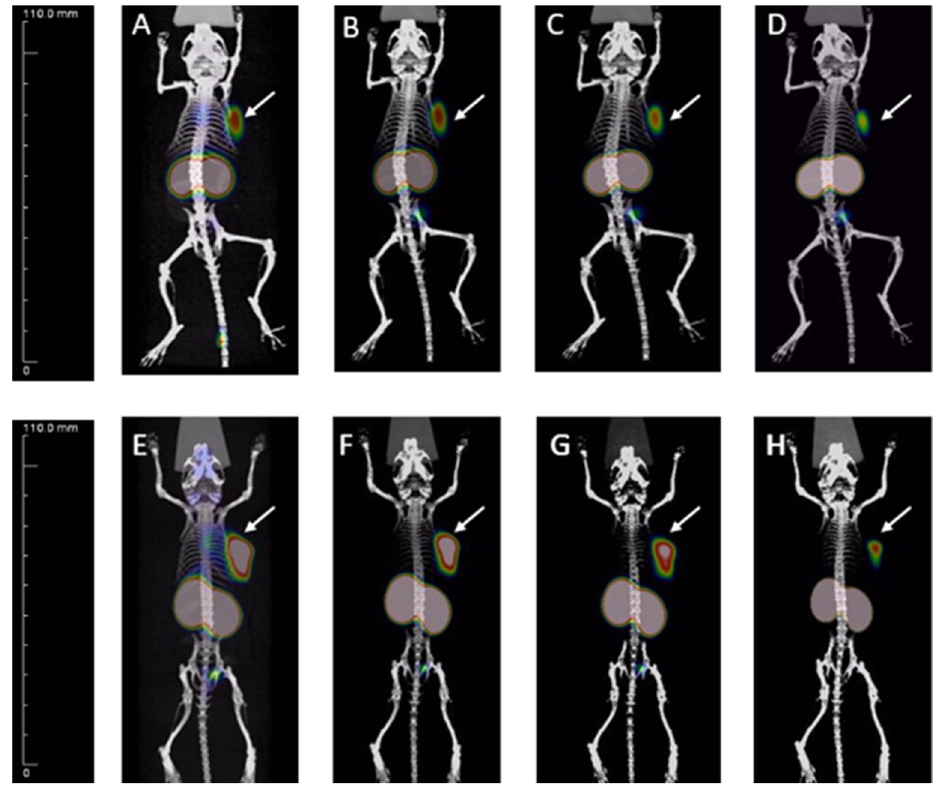
Figure 6. Maximum intensity projection of the whole-body coronal micro-PET/CT images of a NOD/SCID male mouse bearing a LNCaP tumor xenograft (white arrow). The tumor targeting efficacy of 68 Ga-SC691 and 68 Ga-PSMA-11 was demonstrated by time-dependent static scans at 5 min, 30 min, 60 min, and 120 min